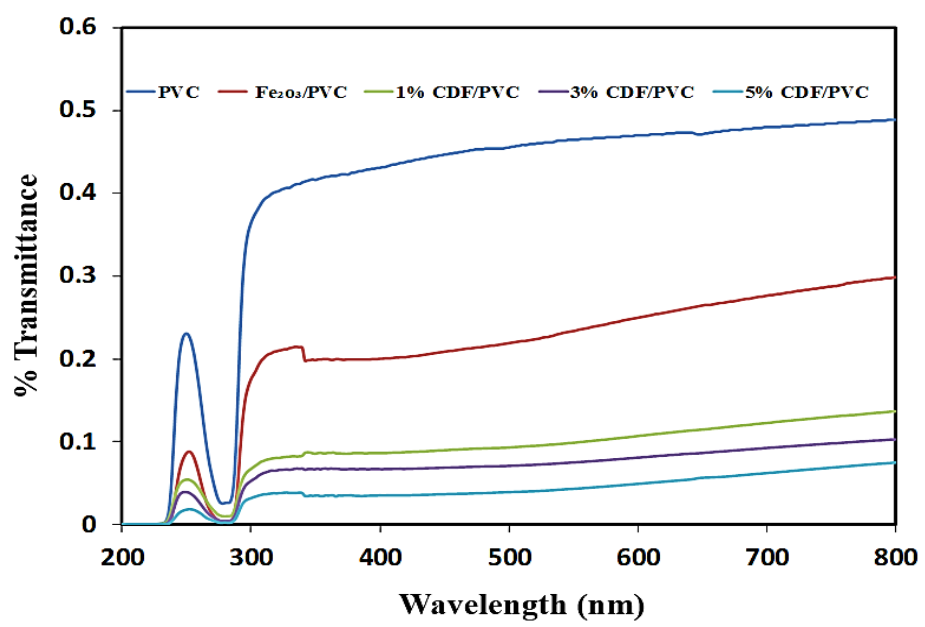
Figure 8. A comparison of transmittance spectra of PVC films and their composites.